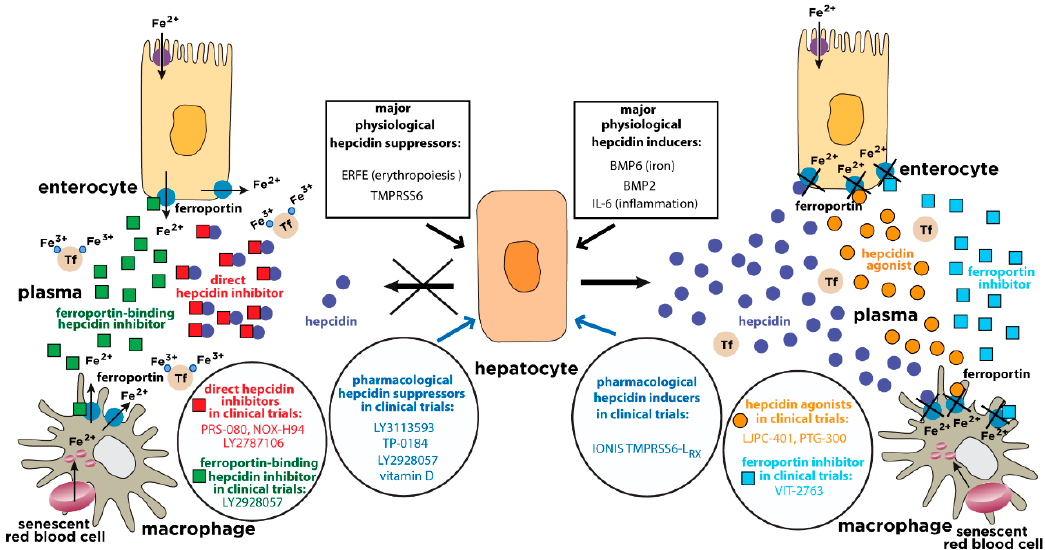
Figure 1. Physiological and pharmacological regulation of hepcidin activity. Hepcidin is synthesized in hepatocytes in response to iron or inflammatory stimuli. It operates by targeting the iron exporter ferroportin in tissue macrophages and duodenal enterocytes. The binding of hepcidin promotes ferroportin degradation, iron retention in target cells and hypoferremia. Suppression of hepcidin by erythropoietic stimuli allows iron efflux from cells into plasma via ferroportin. The expression of hepcidin can be manipulated pharmacologically with drugs that target hepatocytes (blue arrows). Hepcidin responses can be mimicked by hepcidin agonists (orange circles) or ferroportin inhibitors (light blue squares). Conversely, hepcidin responses can be antagonized by direct hepcidin inhibitors (red squares) or ferroportin-binding hepcidin inhibitors (green squares). The insets highlight major physiological hepcidin inducers or suppressors, as well as clinically relevant drugs that modulate the hepcidin-ferroportin axis and are currently being evaluated in randomized controlled trials for the treatment of hepcidin-related disorders (“hepcidinopathies”). Tf, transferrin. The HAMP gene encodes pre-pro-hepcidin, an 84 amino acids long precursor, which is primarily expressed by hepatocytes in the liver, and at much lower levels by other cells in extrahepatic tissues. Pre-pro-hepcidin is processed to pro-hepcidin upon removal of its endoplasmic reticulum targeting